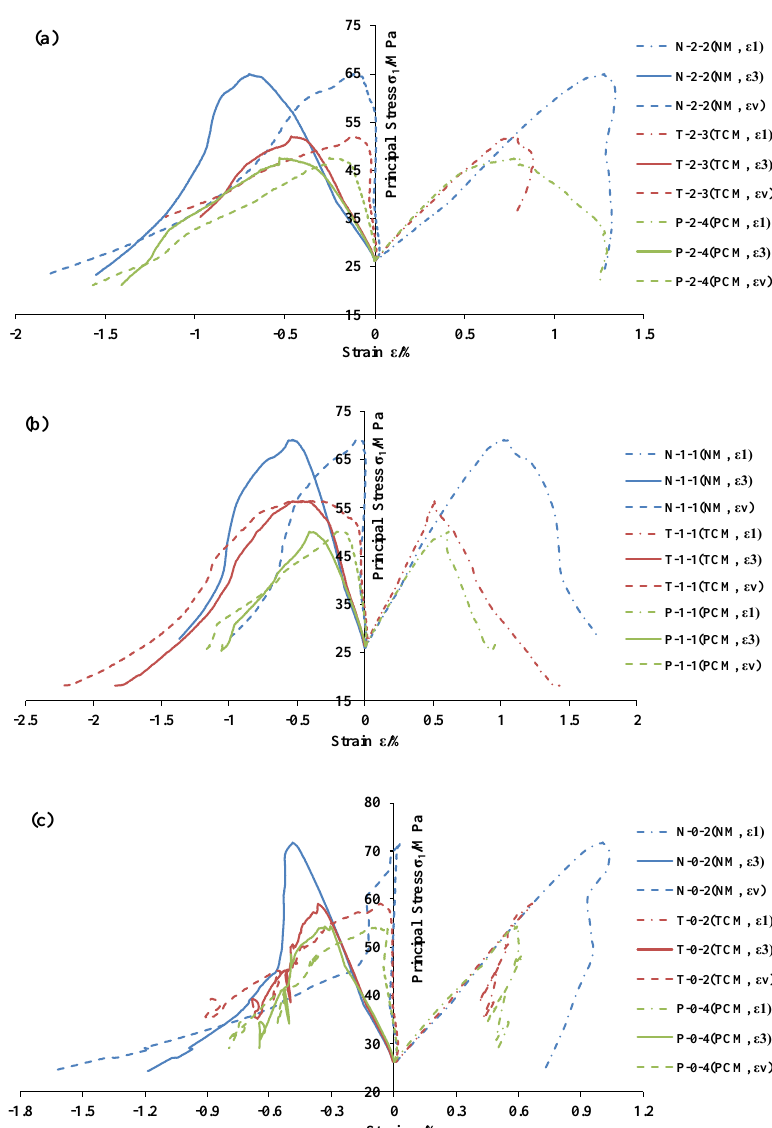
Figure 7. Mining-induced stress-strain curve of a coal sample (N-2-1).